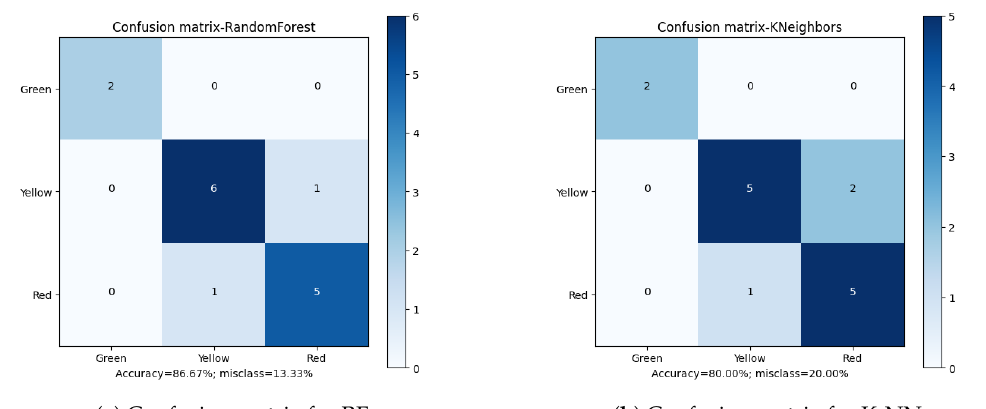
Figure 13. Confusion matrices for Random Forest and K-Nearest Neighbors classifiers.